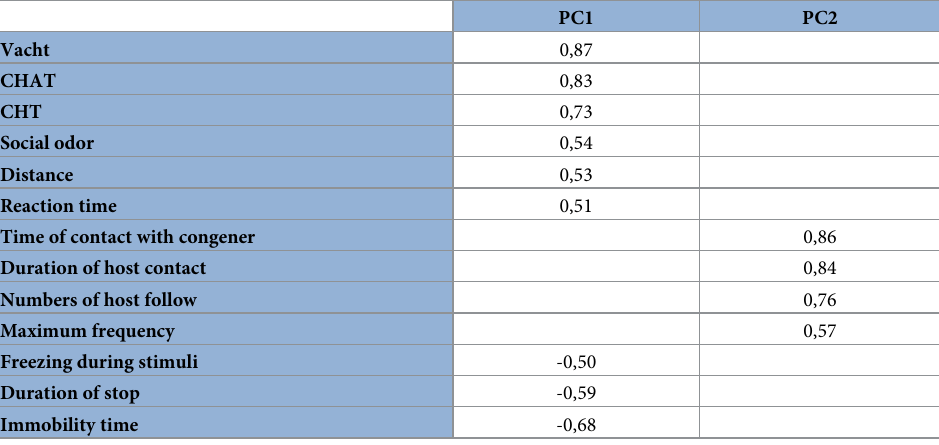
Table 1. Significant results of the PCA performed on the main parameters measured in the behavioral and gene expression experiments. The first component includes cholinergic markers, olfactory reaction to social odor, distance covered in the 3-chamber task and latency to react t a threatening stimulus in the looming task. The second component includes durations of social contact in the SIT, the number of follow episodes and the frequency of USVs. Absence of value indicates no correlation with PCA